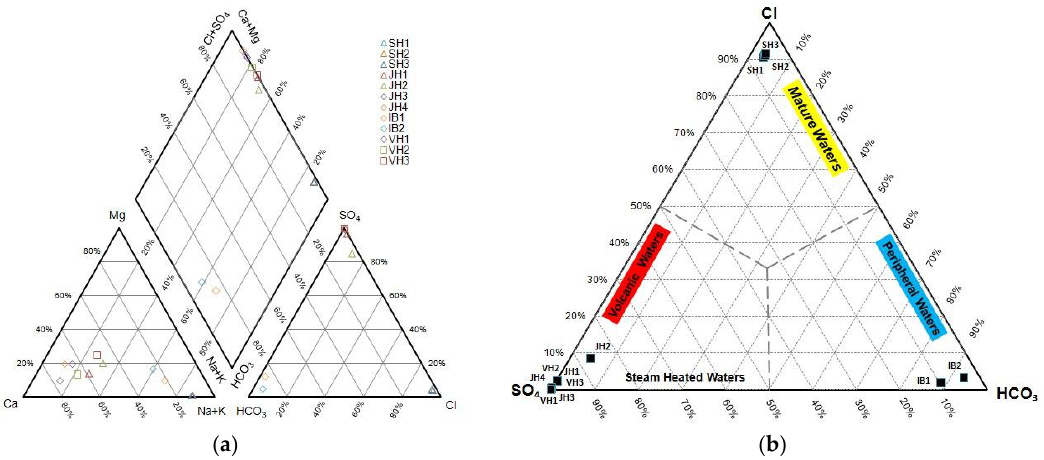
Figure 2. ( a ) Piper diagram for the dominant composition of anion and cation contents; ( b ) Cl-HCO 3 -SO 4 triangle diagram for the geothermal water type in the north zone of Seulawah Agam Mountain.